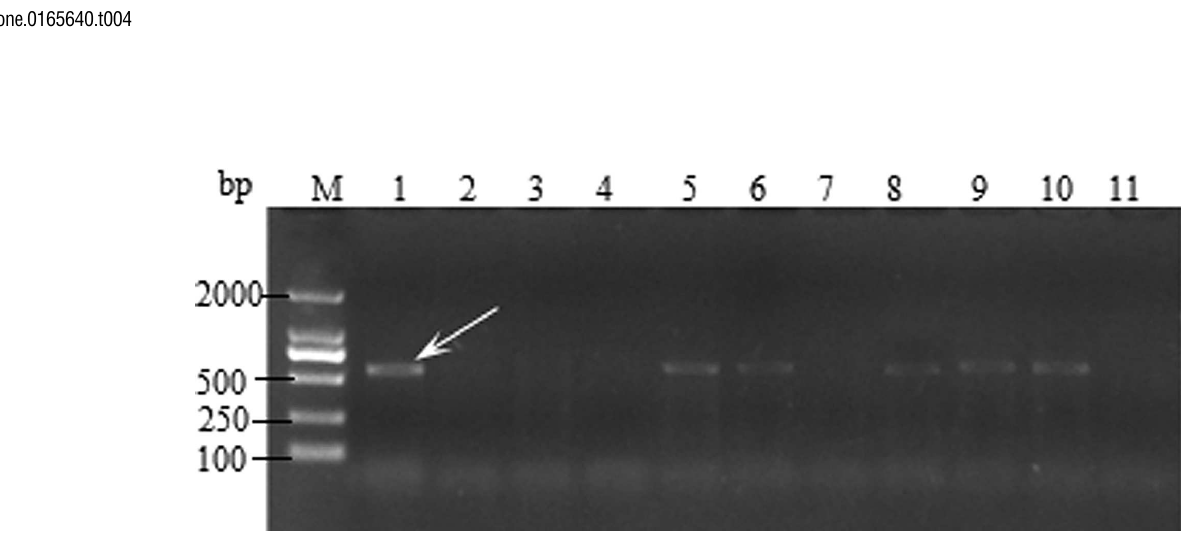
Fig 4. Amplification result for parts of wheat varieties with SCSS30.2 576 . Lane 1–11, Monogenic Sr31 , Little Club, Water control, Fenyin 03–2, Feng 05–394, Yunmai 101, Feng 1124, Yumai 1, Yumai 2, Yumai 3, and Fengmai 31. ‘M’ indicates2000 bp DNA ladder and white arrow indicatesthe position of the specific